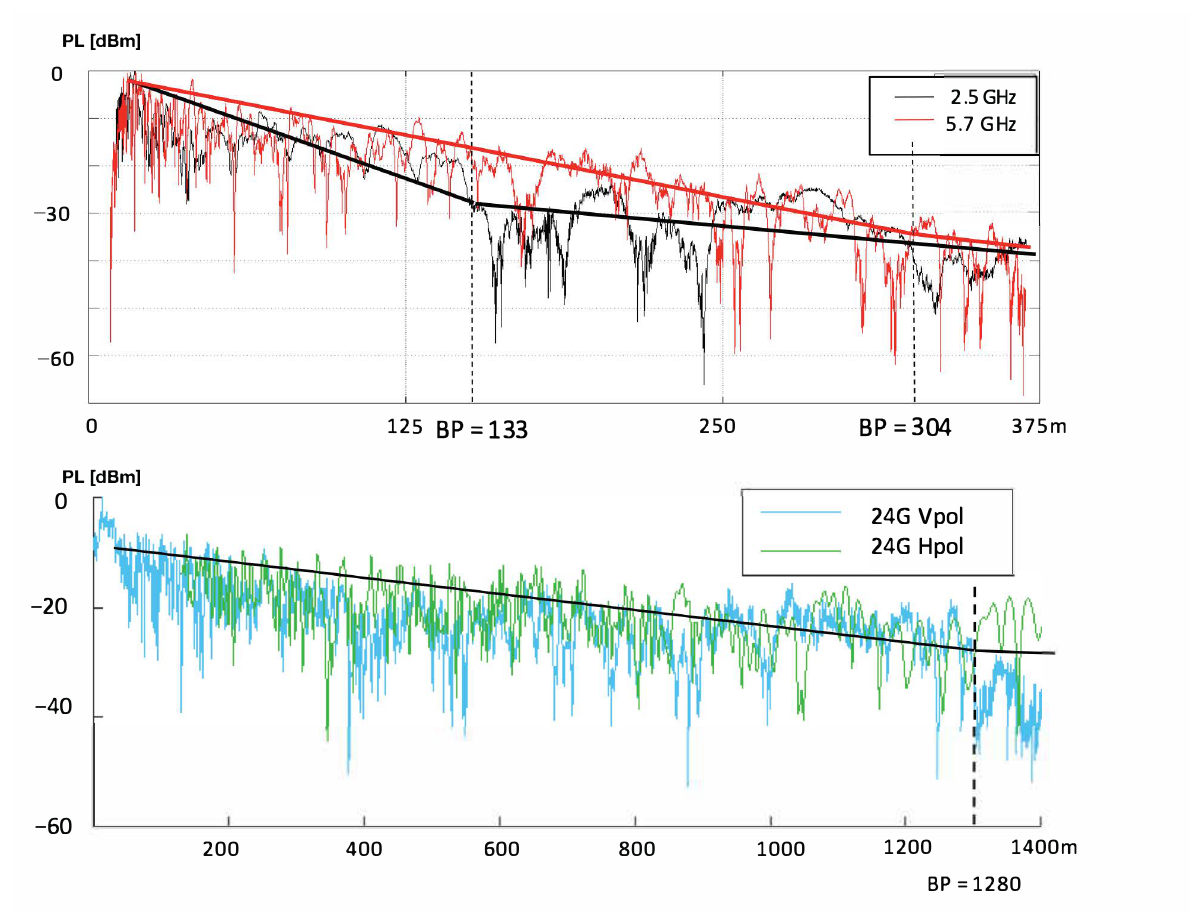
Figure 4. Measurements of Path Losses (PL) at 2.5, 5.7, and 24 GHz, round subway tunnel D = 4 m diameter. Table 4. Parameters of the simulation.